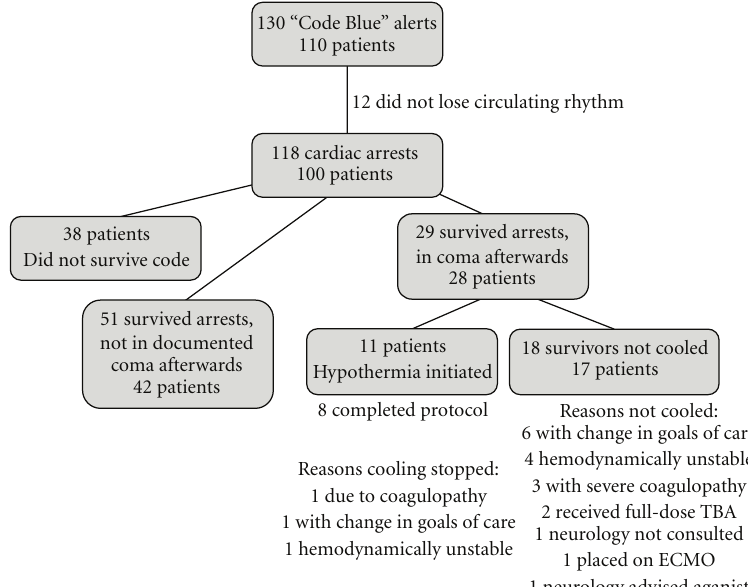
Figure 1: “Code Blue” Alerts at San Francisco VA Medical Center from November 2007 to August 2010. The diagram breaks down the numbers and types of “Code Blue” arrests including brief categorization of reasons of why patients who were comatose after cardiac arrest were not cooled or why cooling was stopped after